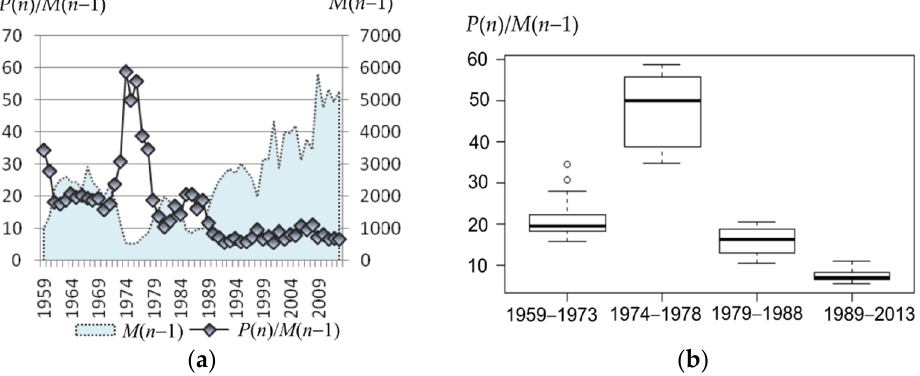
Figure 5. ( a ) Average number of pups per bull ( P ( n )/ M ( n − 1), or average reproductive efficiency, on the left axis, and the number of bulls at the rookery ( M ( n − 1)), on the right axis. ( b ) Box plots of average reproductive efficiency corresponding to the periods: 1959–1973, 1974–1978, 1979–1988, and 1989–2013.